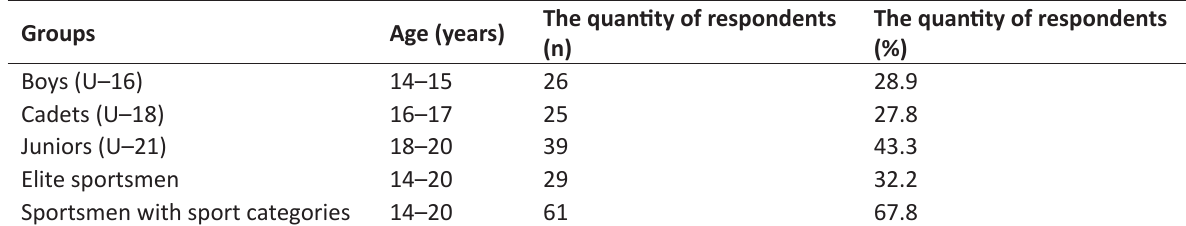
Table 1. Characteristics of athletes